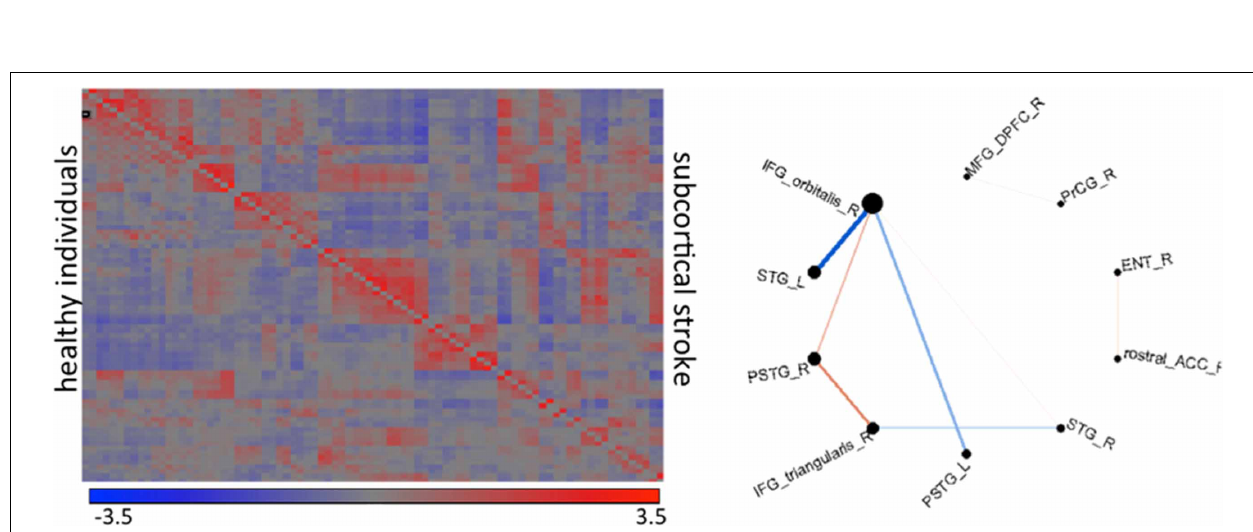
FIGURE 11 | The intensity plot shows average of Fisher-transformed 84 × 84 correlations of rs-fMRI response in atlas partition in individuals with subcortical stroke (superior to the diagonal) and controls (inferior to the diagonal). The diagram shows the connections that are different between groups ( p < 0 . 001); the thickness of the lines is proportional to the ratio of the correlations (stroke/controls); blue are correlations with opposite